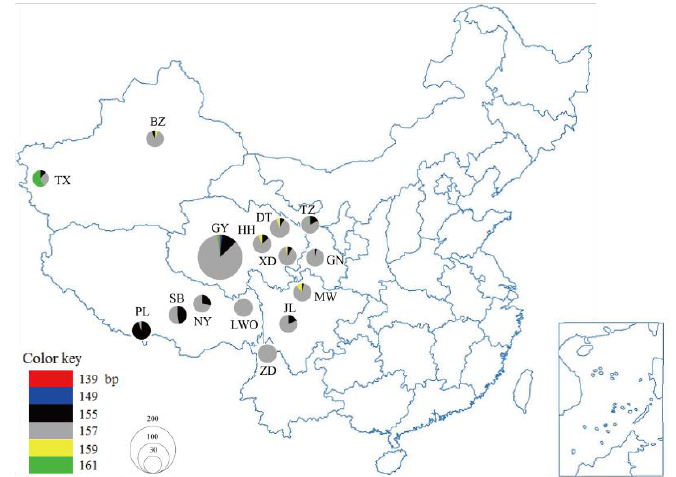
Figure 1. Geographical distribution of six alleles at Y-STR INRA189 locus in 15 Chinese yak breeds/populations. Circle area is proportional to the sample size. GY, Gaoyuan; DT, Datong; HH, Huanhu; XD, Xueduo; TZ, Tianzhu; GN, Gannan; JL, Jiulong; MW, Maiwa; SB, Sibu; NY, Niangya; PL, Pali; LWQ, Leiwuqi; BZ, Bazhou; TX, Taxian, and ZD,